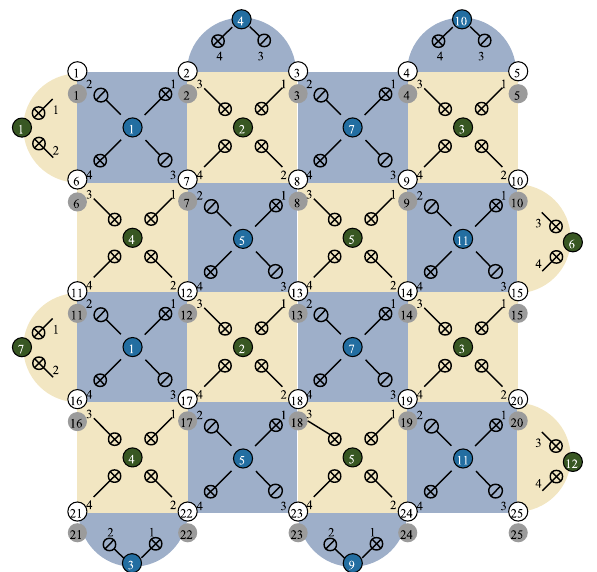
Fig. 3 Schematic diagram of surface-GKP code with a code distance of 5. The small white circles in the surface-GKP code with code distance d = 5 represent the data GKP qubits, and the small gray circles correspond to each data GKP qubit one-to-one, which is used to measure the auxiliary GKP quantum of the stabilizer of the data GKP qubit bits. The small dark green circles and the small dark blue circles represent the syndrome qubits of the surface-GKP code, which are used to measure the Z type and X type surface code stabilizers of the data GKP qubit, respectively. The data GKP qubits and auxiliary bits corresponding to the light yellow and light blue squares and the corresponding SUM gates and inverse gates constitute the stabilizer